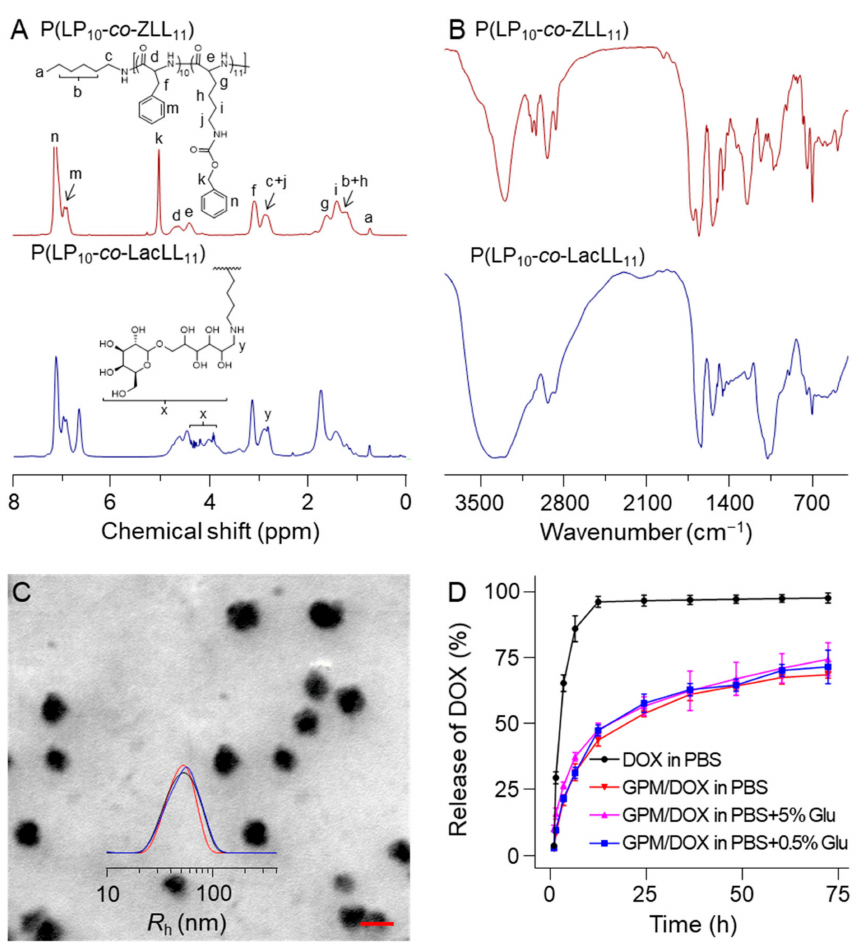
Figure 1. ( A ) 1 H NMR (in TFA- d ); ( B ) FT-IR spectra of P(LP 10 - co -ZLL 11 ), P(LP 10 - co -LL 11 ), and P(LP 10 - co -LacLL 11 ); ( C ) SEM microimages and R h of GPM; and ( D ) release of free DOX and GPM/DOX in PBS containing different concentrations of Glu. Here, each set of data is represented as mean ± standard deviation (SD) ( n = 3); scale bar = 100